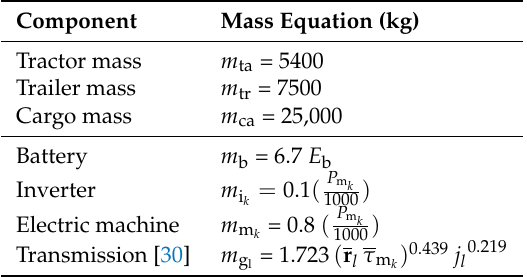
Table 4. Mass models of powertrain